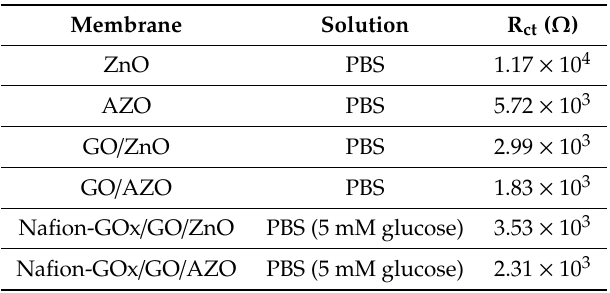
Table 2. Charge transfer resistances obtained by the fitting of EIS. PBS: phosphate-bu ff ered